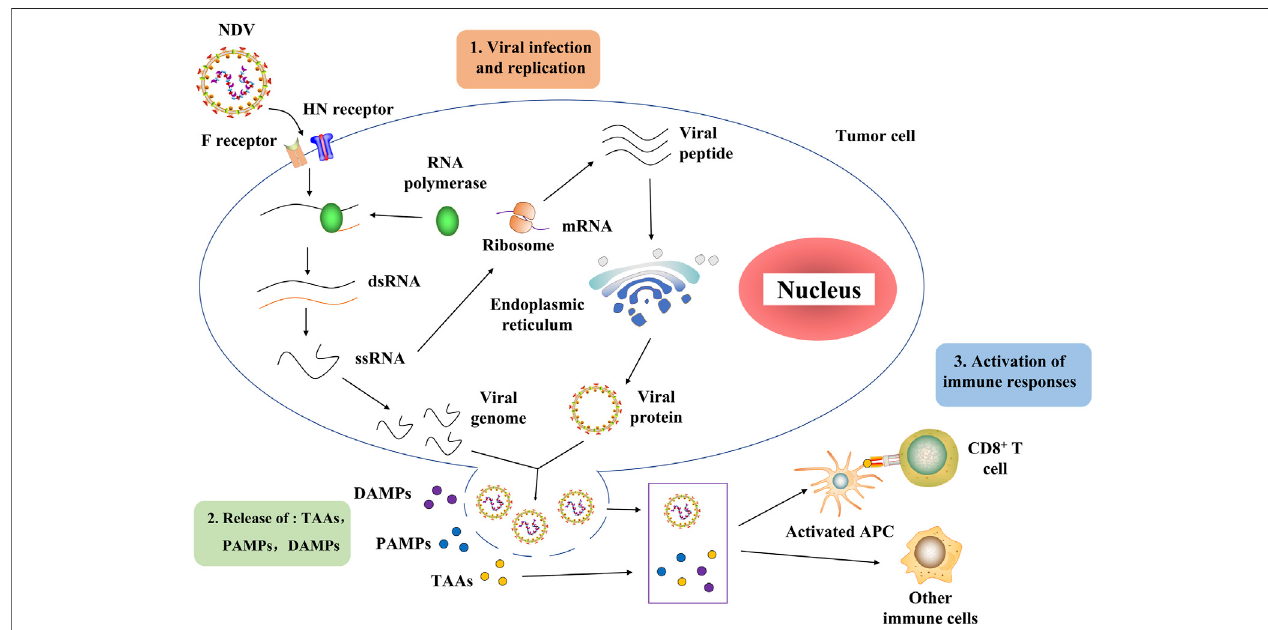
FIGURE 2| Process ofNDV through which itinfects tumor cells and activates the host immune system. NDV exerts its antitumor effect mainly in two stages. In the fi rst stage, the NDV binds to the sialic acid receptor on the surface of tumor cells through the HN protein, and then protein F initiates the fusion of the viral and host cell membranes. Then, the viral RNA polymerase transcribes the viral negative single-stranded RNA into positive single-stranded RNA as a template for mRNA and protein synthesis. The rough endoplasmic reticulum processes surface proteins F and HN, assembled on the host cell membrane and germinated to produce new virions that begin a new round of tumor cell infection. In the second stage, the virus-mediated direct oncolysis leads to the release of TAAs, PAMPs, and DAMPs that activate APCs,includingdendriticcellscapableofantigencross-presentation.ActivatedAPCsactivateimmunecells,resultinginthegenerationofCD4 + Tcells,CD8 + Tcells,and NK cells directed toward tumor and viral antigens. NDV, Newcastle disease virus; HN, hemagglutinin – neuraminidase; F, fusion protein; dsRNA, double-stranded RNA; ssRNA, single-stranded RNA; TAAs, tumor-associated antigens, PAMPs, pathogen-associated molecular patterns, DAMPs, danger-associated molecular patterns; APCs, antigen-presenting